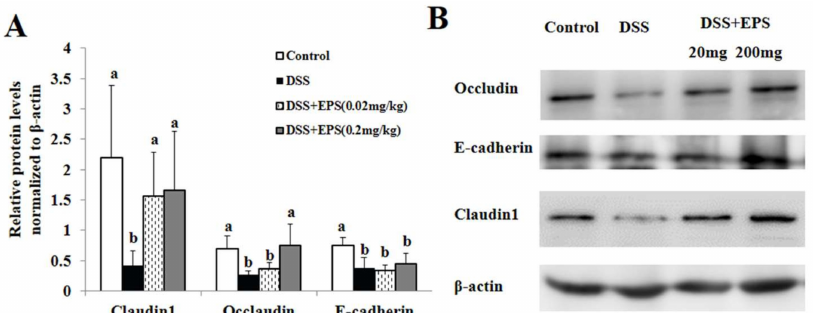
Figure 4. EPS-1 Relieved DSS-Induced Colonic Epithelial Tight Junction Disruption in Mice. ( A ) Relative protein levels of Occludin, E-cadherin and Claudin1 in the colon tissues normalized to β -actin. ( B ) Protein expression of Occludin, E-cadherin, and Claudin-1 in the colon tissues were analyzed by Western blot. Values with different superscript letters (a, b,) are significantly different ( p <